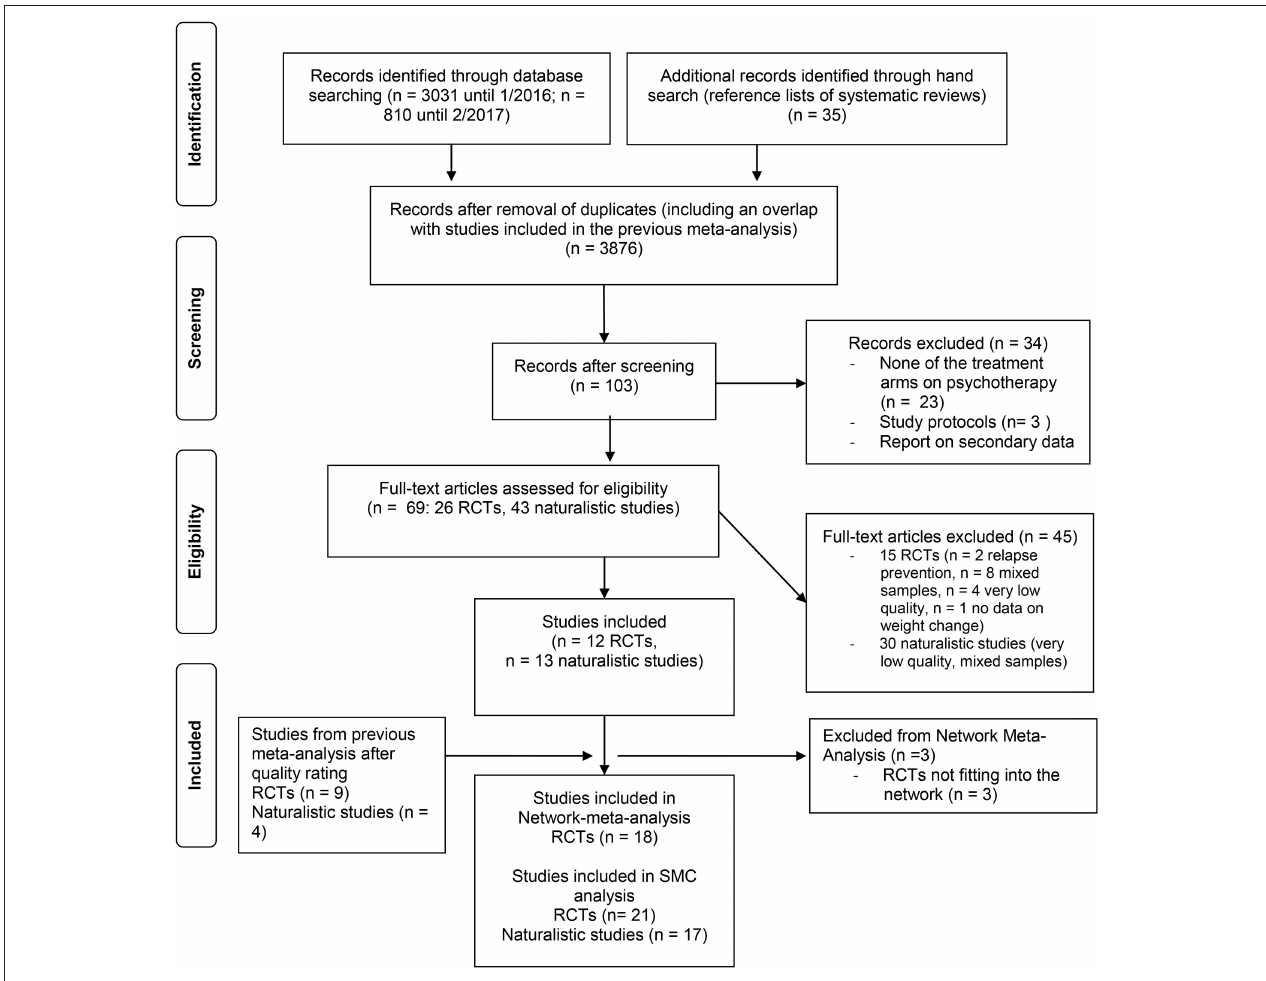
FIGURE 1 | PRISMA flow chart, study selection